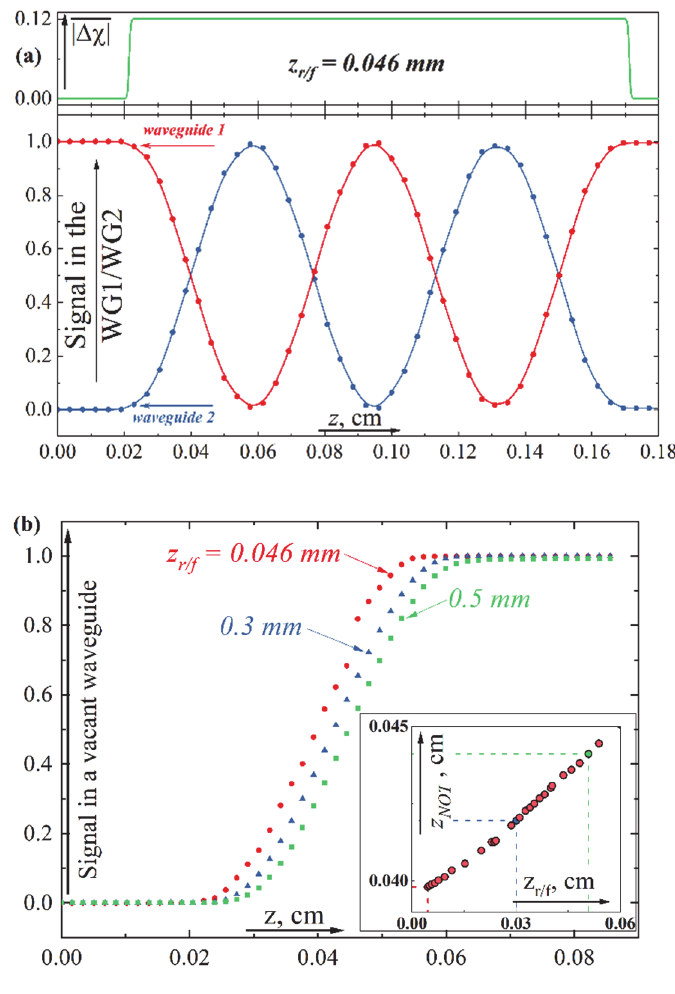
Figure 3. ( a ) The signal in the first/second waveguide versus z -coordinate for the smoothed function ∆ χ ( z ) , z r/f ≈ 0.046 mm. The upper part of the figure presents a decrease in the “height” of the barrier separating the waveguides (minima of the double-well potential) along the z -axes. ( b ) The signal in a vacant waveguide versus z -coordinate for the NOT-operation. The inset shows how the spatial size required for the NOT operation increases with the degree of smoothing ∆ χ ( z ) Another possible way to realize the optical “convertor” is to control the symmetry of the double ‐ well potential by changing the depth of one of the wells. In optics, it means